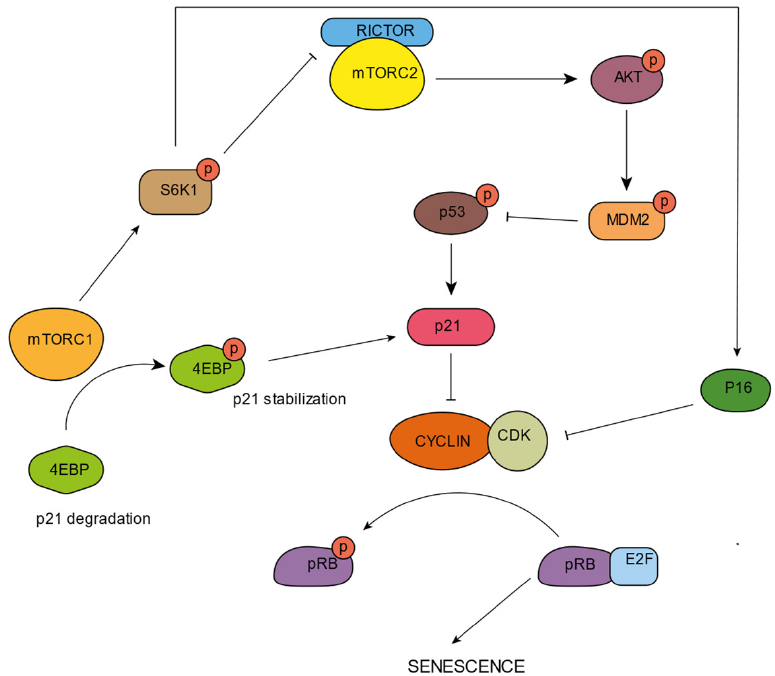
Figure 3. An overview of mTORC1 and mTORC2 on senescence control by the regulation of the p53/p21 and p16/pRb pathways. p21 is stabilized through mTORC1 dependent 4EBP phosphoryla- tion, and through mTORC1 via S6K1 dependent mTORC2 inhibition, which has repercussions on p53 stabilization. p16 is activated downstream of mTORC1 by S6K1 phosphorylation, inhibiting the CDK–Cyclin complexes and impeding pRb phosphorylation. This results in the sequestration of E2F and the prevention of cell cycle progression, eventually leading to senescence.